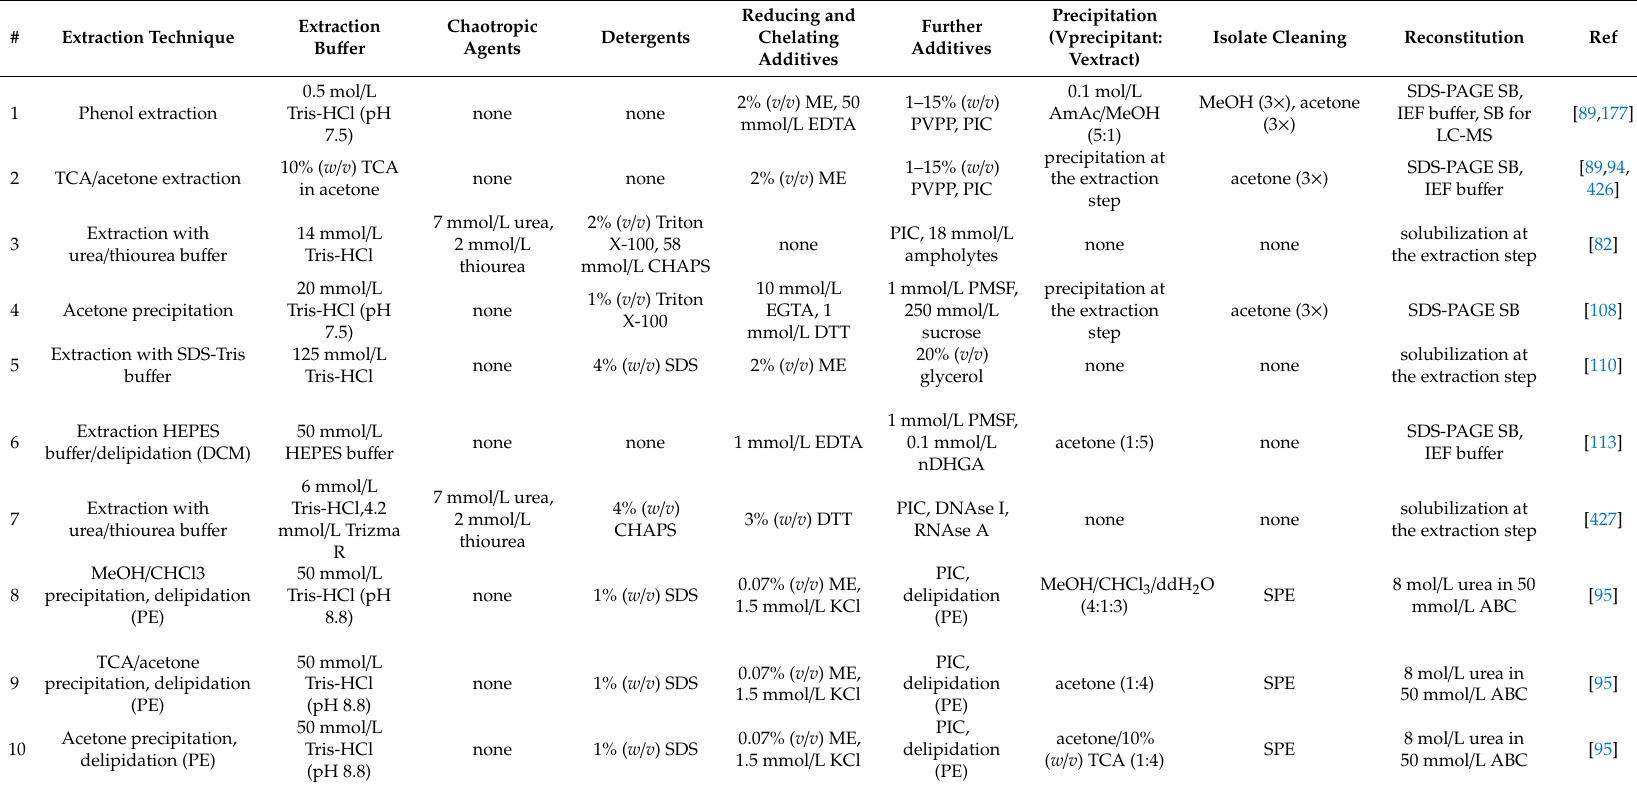
Table A1. Overview of protein extraction